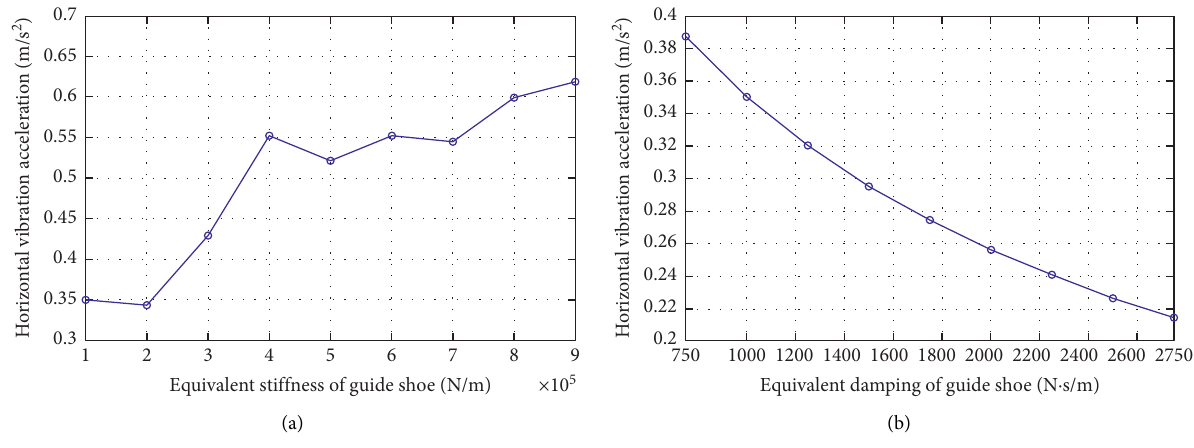
Figure 7: Influence of dynamic parameters of the roller guide shoe on horizontal vibration. (a) Influence of equivalent stiffness. (b) Influence of equivalent damping.